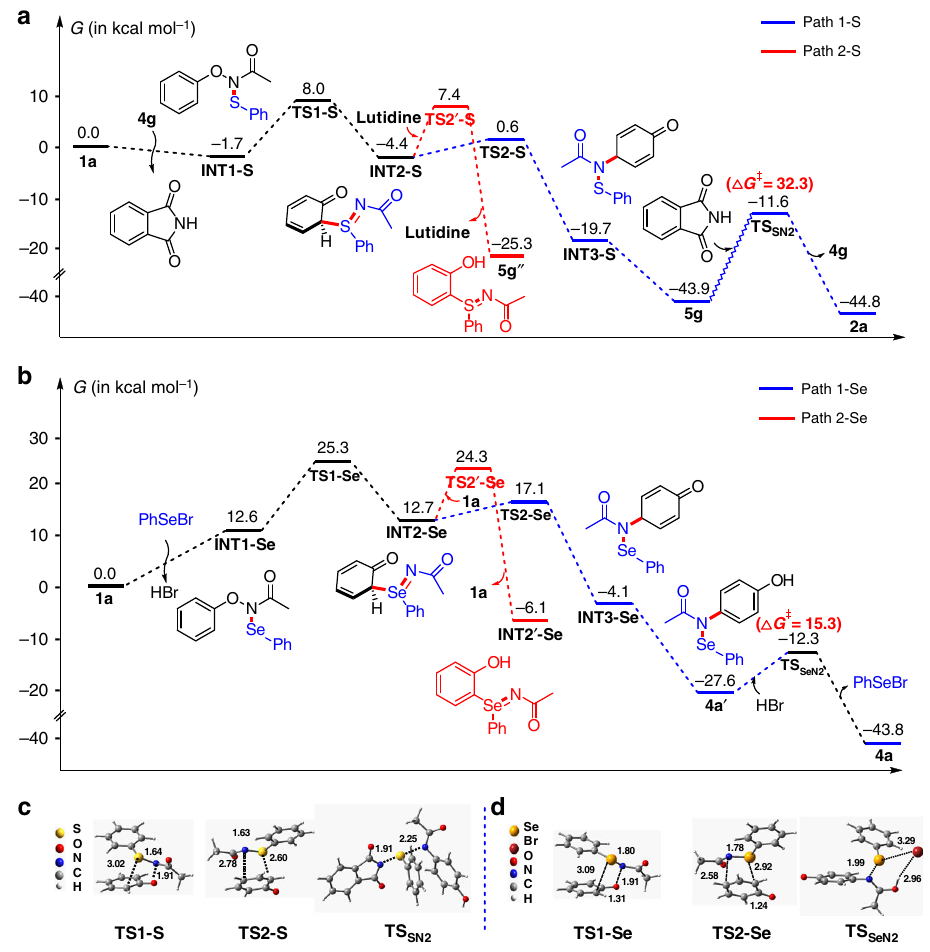
Fig. 3 Computational studies on S (and Se)-mediated para -selective nitrogen migration of N- phenoxyacetamide ( 1a ). a Computed Gibbs energy pro fi le for S-mediated reaction (in TFE). b Computed Gibbs energy pro fi le for Se-catalysed reaction (in 1,4-dioxane). c Transition states involved in S-mediated reaction. d Transition states involved in Se-catalysed